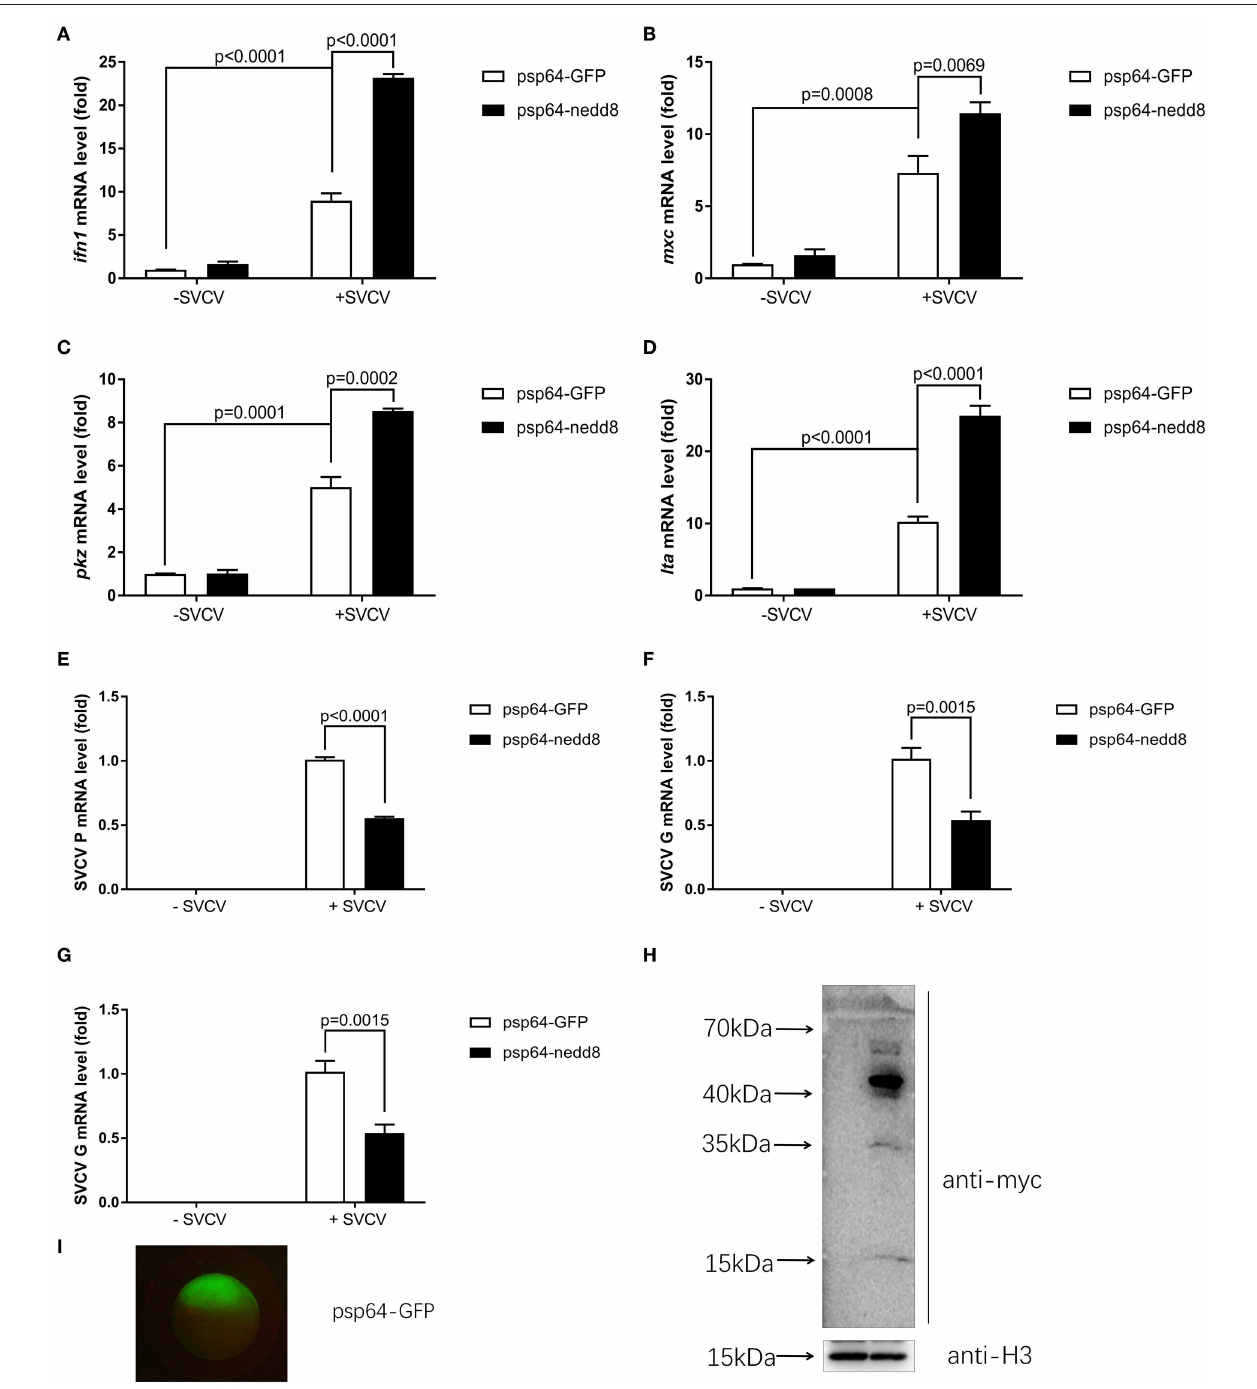
FIGURE 6 | Overexpression of nedd8 upregulates key antiviral genes after SVCV infection and suppresses viral replication in vivo . (A–D) Ectopic expression of nedd8, induced by mRNA injection upregulated key antiviral genes in SVCV infected zebrafish larvae. We injected zebrafish embryos at the one-cell stage with either GFP mRNA (400 pg/per embryo) or Myc-tagged nedd8 mRNA (400 pg/per embryo). At 3 dpf, we added SVCV viruses (2 × 10 8 TCID 50 /ml) into the water containing zebrafish larvae. After incubation for 24h, we extracted total RNA from all larvae and performed qPCR assays to detect the expression levels of ifn1 (A) , mxc (B) , and pkz (C) and lta (D) . (E–G) Ectopic expression of nedd8 by mRNA injection suppressed SVCV replication in embryos. We performed qRT-PCR assays to detect the expression levels of the SVCV genes P (E) , G (F) , and N (G) genes of SVCV. (H,I) Western blot assay and Fluorescence micrographs of zebrafish embryos showed the expression levels of injected GFP mRNA or Myc- nedd8 mRNA. Data are shown as mean ± SEM of three independent experiments, each performed in triplicate; the statistical analysis was performed using GraphPad Prism 5 (unpaired t -test).